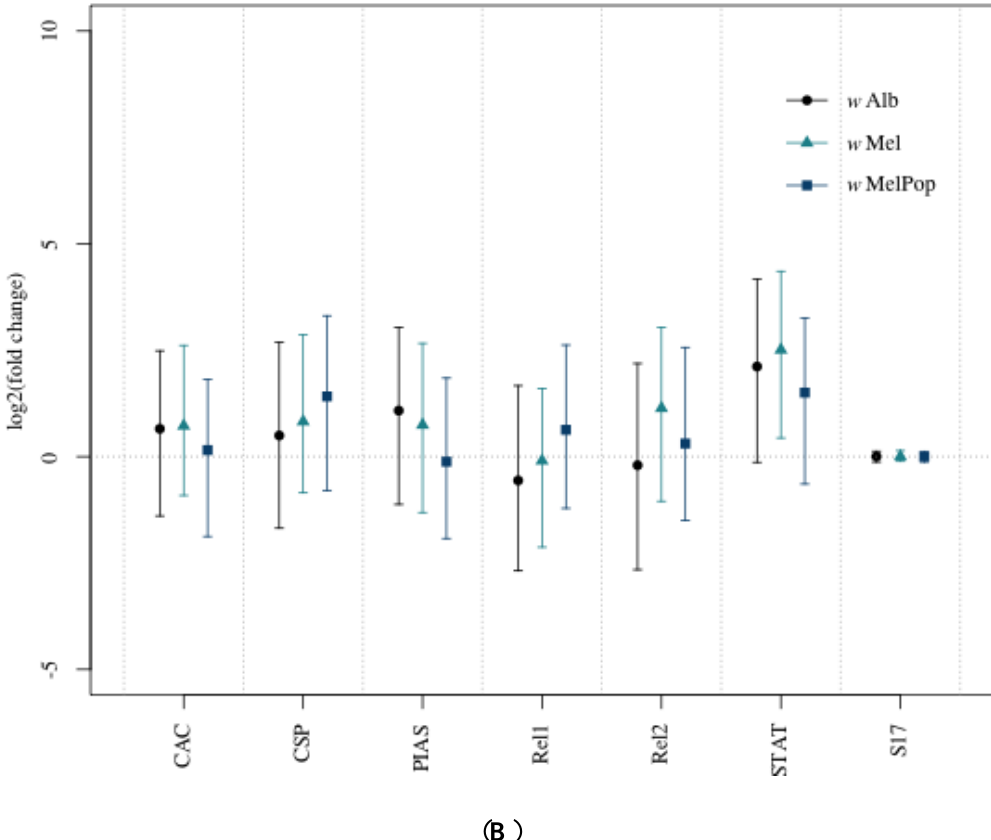
Figure 1. ( A ) Ratio of Wolbachia genome copies to Ae. albopictus genome copies detected in Aa23-T. w AlbB, Aa23-T. w Mel and Aa23-T. w MelPop cell lines. Genome copies were determined by absolute quantification using a standard curve of plasmid DNA containing the genes of interest. Results are from two or three biological replicates; ( B ) Immune pathway gene transcription in Ae. albopictus Aa23-T. w AlbB, Aa23-T. w Mel and Aa23-T. w MelPop cell lines compared to Aa23-T, normalised to the housekeeping gene S17. Points represent the mean of three biological replicates and error bars denote 95% confidence intervals calculated using Bayesian MCMC methods in MCMC.qPCR R package. Immune gene transcription in the